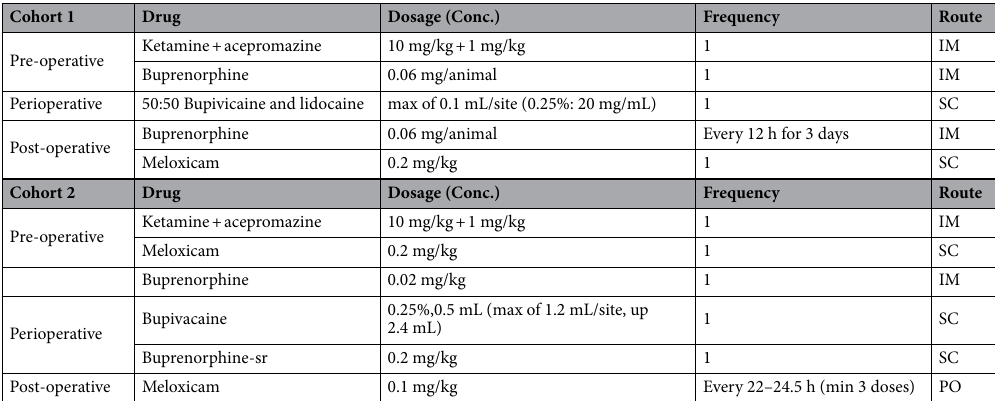
Table 1. Multimodal perioperative analgesic regimen for cohort 1 and 2